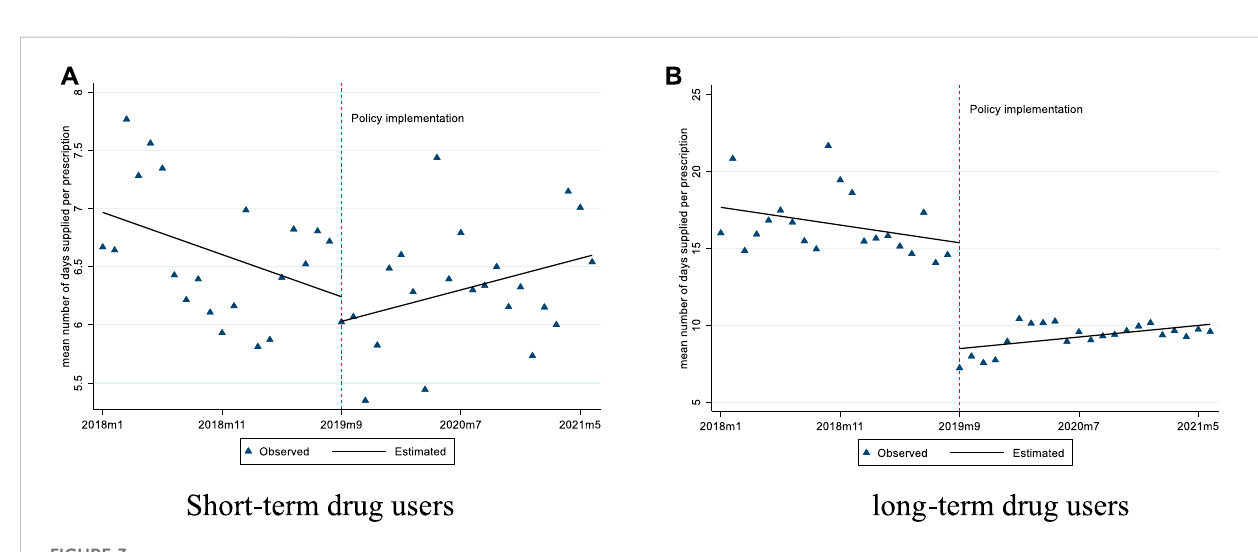
FIGURE 3 Changes in the mean number of days supplied per prescription for short-term and long-term drug users. (A) Short-term drug users (B) long-term drug